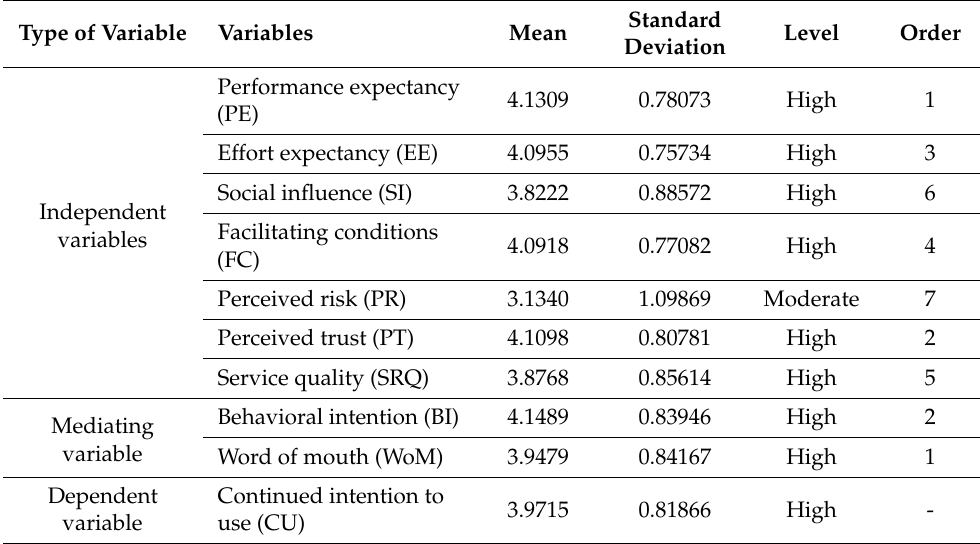
Table 3. Overall mean and standard deviation of the study’s variables. Type of Variable